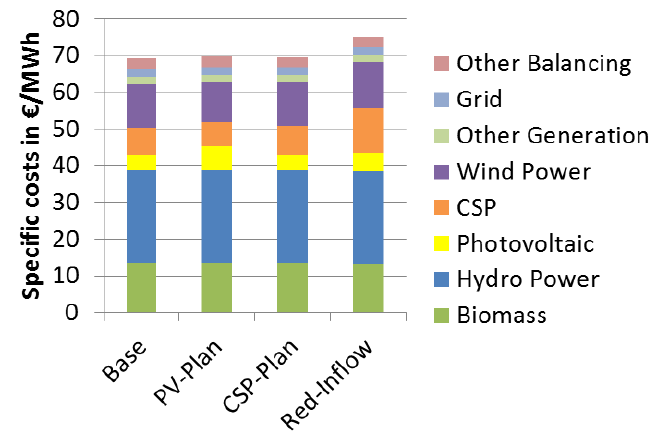
Figure 9. Calculated power supply costs per unit of demand, subdivided by technology in 2050.